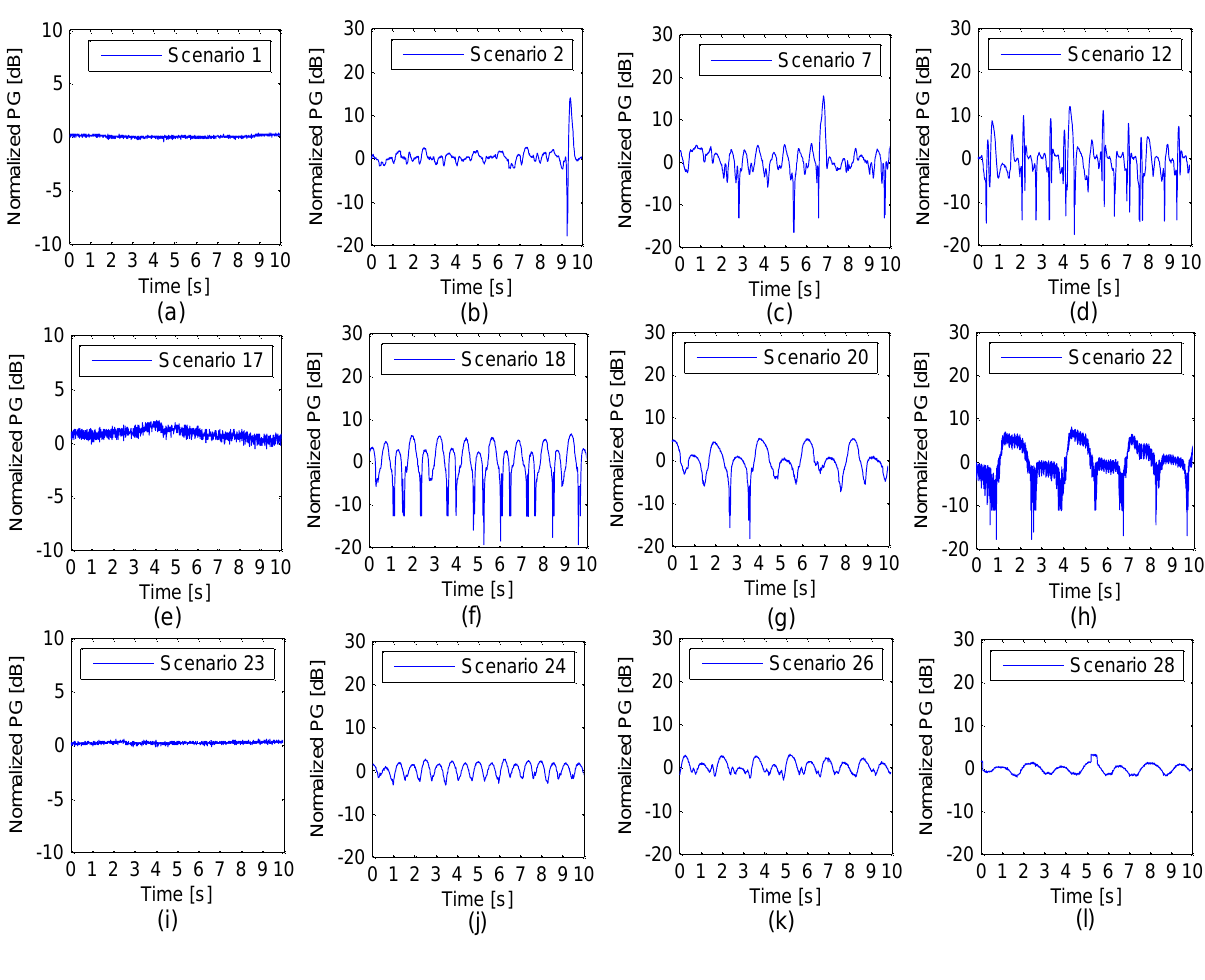
Figure 3. Temporal variations in the normalized path gain across 10 seconds of snapshot data for ( a ) scenario 1, ( b ) scenario 2, ( c ) scenario 7, ( d ) scenario 12, ( e ) scenario 17, ( f ) scenario 18, ( g ) scenario 20, ( h ) scenario 22, ( i ) scenario 23, ( j ) scenario 24, ( k ) scenario 26 and ( l ) scenario